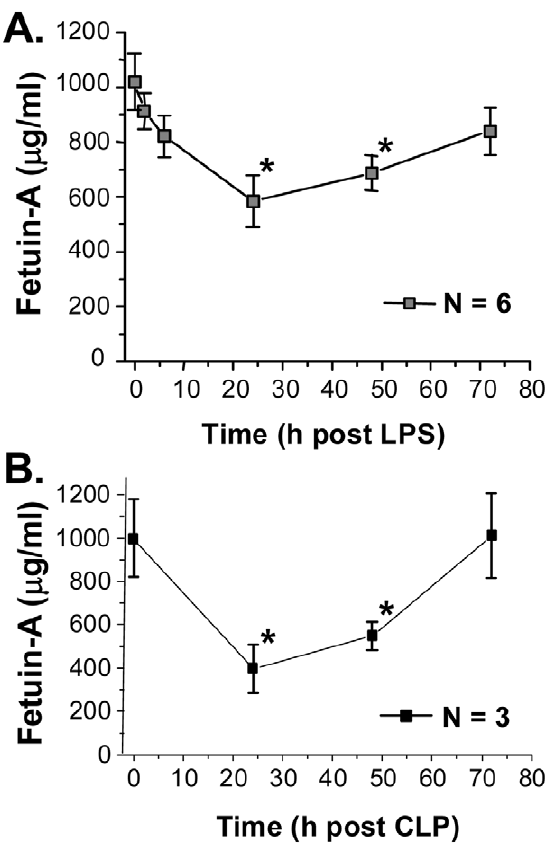
Figure 1. Circulating fetuin-A levels were temporally decreased during endotoxemia and sepsis. Balb/C mice were subjected to endotoxemia (LPS, 10 mg/kg, i.p.) or sepsis (induced by CLP), and sacrificed at indicated time points to collect blood. Serum fetuin-A levels were determined by Western blotting analysis with reference to standard curve generated with purified fetuin-A at various dilutions, and expressed as mean 6 SD of 3–6 independent experiments (N=3– 6), with 4–6 animals included in each group. *, P , 0.05 versus ‘‘0 h post LPS’’ ( Panel A ) or ‘‘0 h post CLP’’ ( Panel B ).